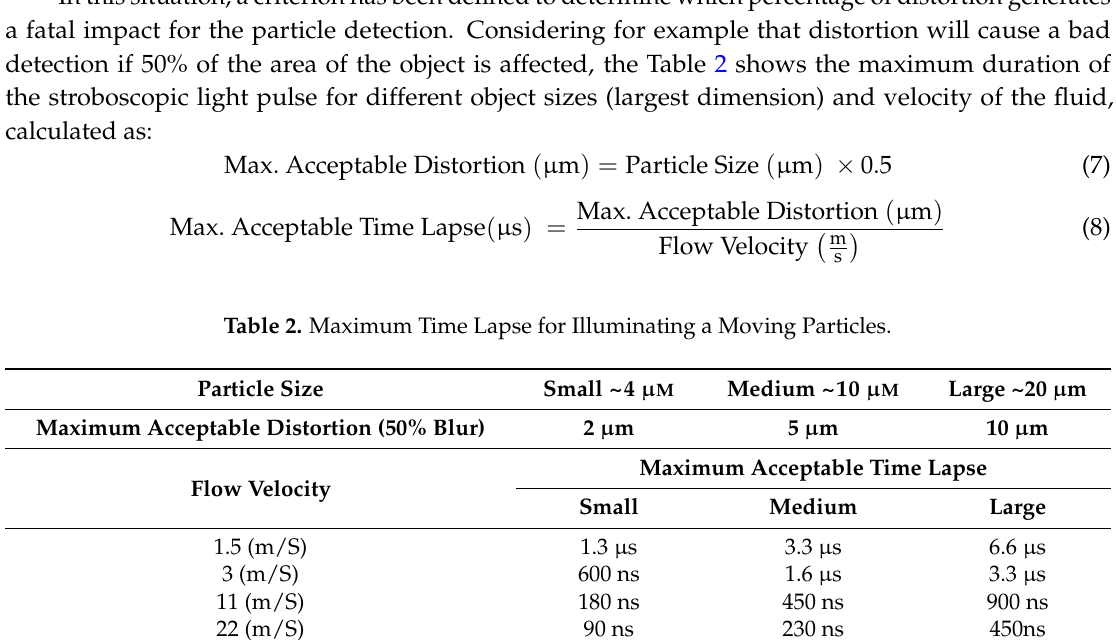
Figure 16. Impact of the object distortion (images on the right column) on its recognition through machine vision depending on its original size (images on the left column) for a given flowing and illumination conditions.